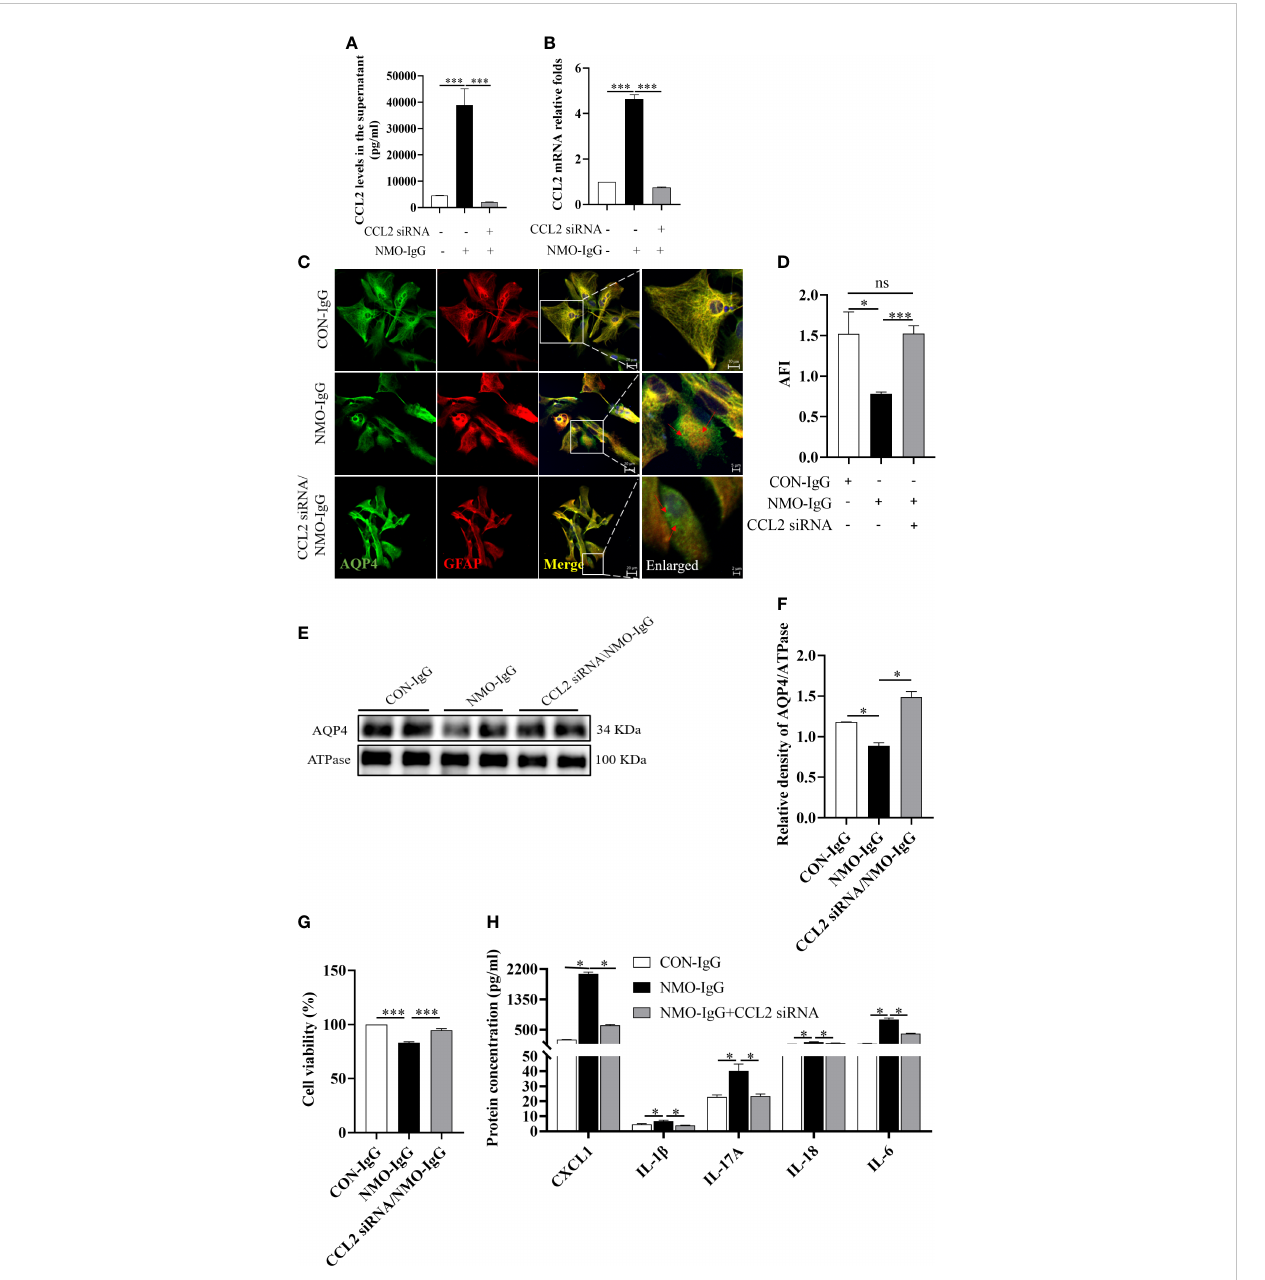
FIGURE 4 The effect of CCL2 siRNA on NMO-IgG-induced astrocyte damage. Interfering with CCL2 siRNA dramatically inhibited the release of CCL2 soluble proteins into the supernatant (A) and the expression of CCL2 mRNA (B) produced by NMO-IgG incubation. (C) Following interference with CCL2 expression by pretreatment with CCL2 siRNA, the degree of AQP4 aggregation into granules of the cell membrane or internalization into the cytoplasm was markedly reduced in the NMO-IgG-treated group. The scale bars in merged and enlarged pictures are 20 and 5 m m, respectively. (D) Compared with the NMO-IgG group, CCL2 siRNA signi fi cantly prevented the NMO-IgG-induced drop in AFI. (E) The protein expression of AQP4 on the cytomembrane was signi fi cantly lower in the NMO-IgG group than in the CON-IgG group, whereas there was no signi fi cant drop in the CCL2 siRNA/NMO-IgG group. (F) The ratio of AQP4 optical density to its internal reference, ATPase, is shown. (G) A high concentration of NMO-IgG (8 U) severely reduced cell viability in rat primary astrocytes. Impressively, the damage caused by NMO-IgG at the high concentration could be reversed following CCL2 interference. (H) Interfering with CCL2 siRNA signi fi cantly reduced the release of various additional in fl ammatory factors, including CXCL1, IL-1, IL-17A, IL-18, and IL-6. Data are presented as the mean ± SE of three or fi ve independent experiments. * p < 0.05, *** p < 0.001; ns, not signi fi cant ( p > 0.05). The red arrows indicate areas of AQP4 protein